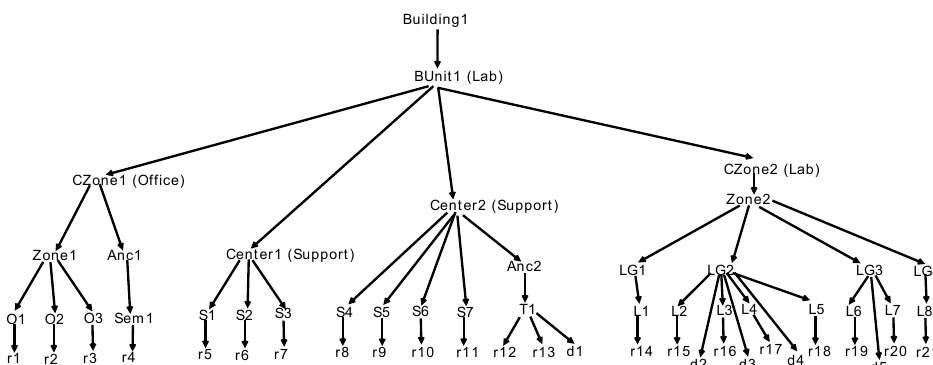
Figure 13. Parse tree with highest probability for floor-plan (d).